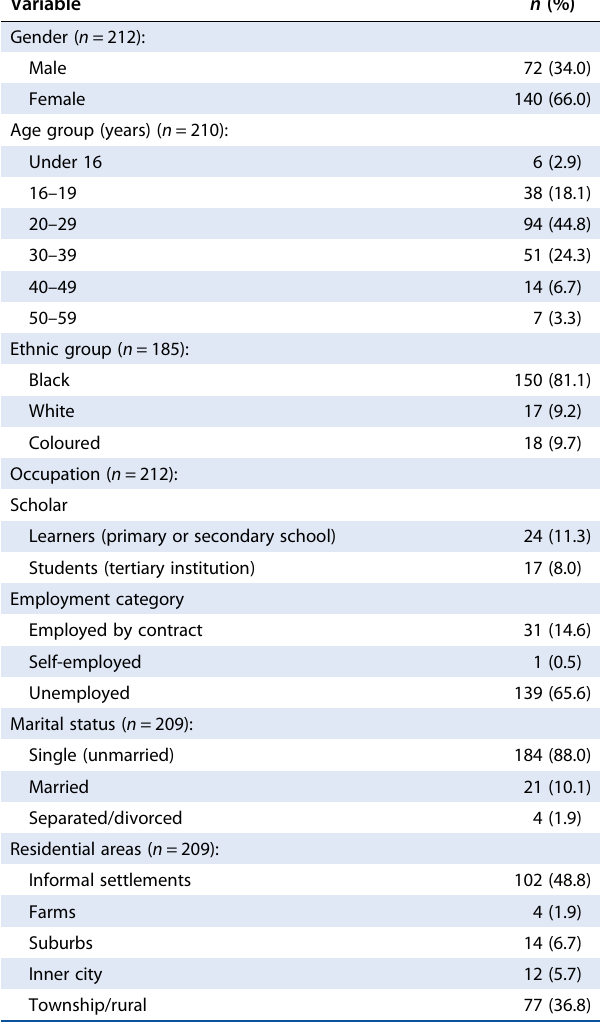
Table 1: General demographics of patients who were treated at Pelonomi Regional Hospital emergency department for deliberate self-poisoning